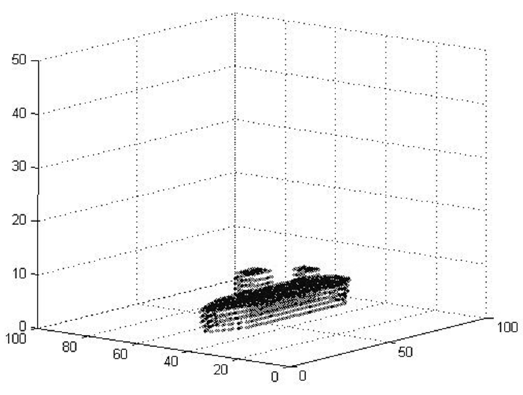
Figure 2. The 3D geometry of the ship target.